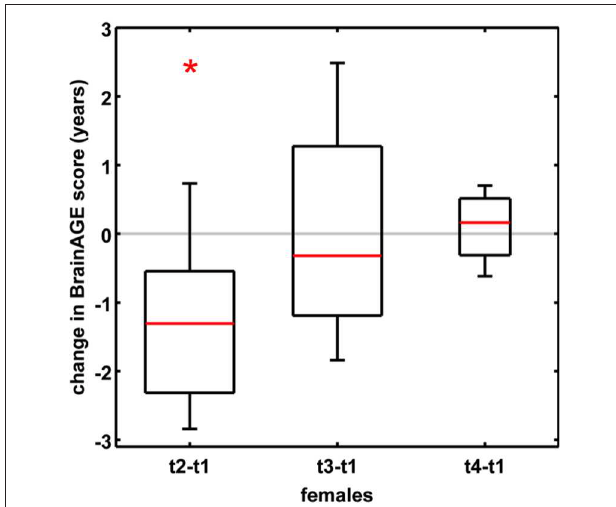
FIGURE 4 | Change in BrainAGE scores during the menstrual cycle. BrainAGE scores significantly decreased by − 1.3 years (SD = 1.2) at time of ovulation (i.e., t2-t1; * p < 0.05). The data are displayed as boxplots, containing the values between the 25th and 75th percentiles of the samples, including the median (red lines). Lines extending above and below each box symbolize data within 1.5 times the interquartile range. The width of the boxes depends on the sample size. Note: reduced sample size at t4. [Figure and legend reproduced from Franke et al. (35), with permission from Elsevier,